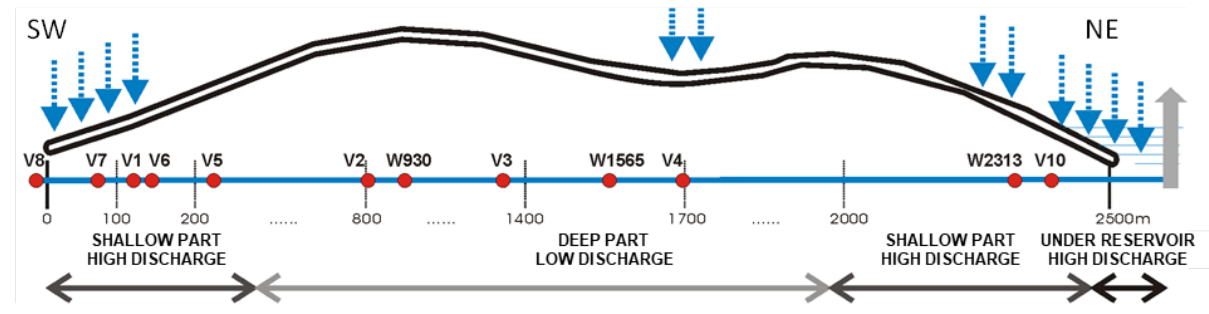
Fig. 1. Basic diagram of Bed˚richov tunnel with the positions of selected discharge points and representation of the overburden.